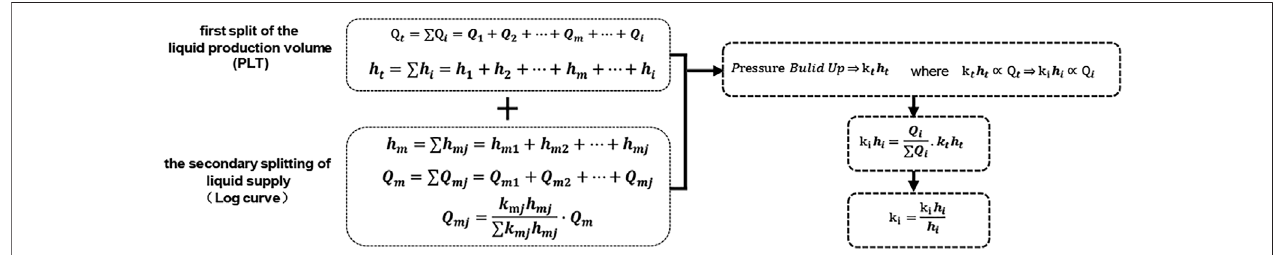
FIGURE 3 | The work fl ow of single-well dynamic permeability splitting iterative algorithm.